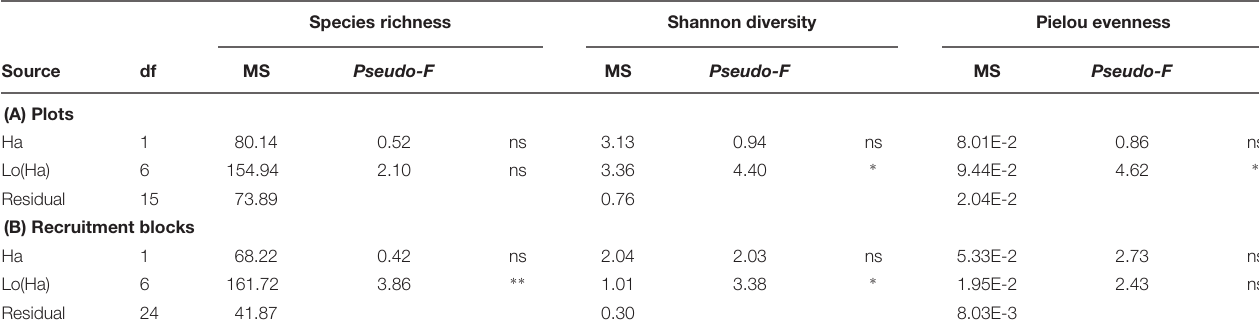
TABLE 4 | perMANOVA comparing alpha diversity (species richness, Shannon’s diversity, Pielou’s evenness) sampled directly from natural rocky shores and artificial seawalls ((A) Plots) and from substrate experimentally deployed in the habitat ((B) Recruitment blocks). Species richness